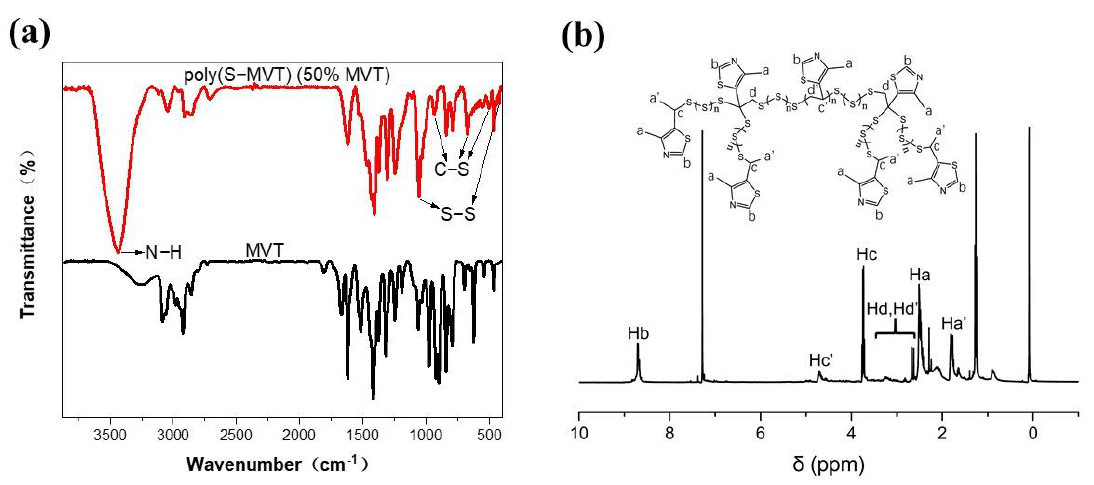
Figure 1. ( a ) FTIR spectra of MVT and Poly(S-MVT) (50% MVT); ( b ) HNMR spectra of poly(S-MVT) (15% MVT). The 1 H-NMR spectra of all poly(S-MVT)s (Figure S5) clearly indicated the